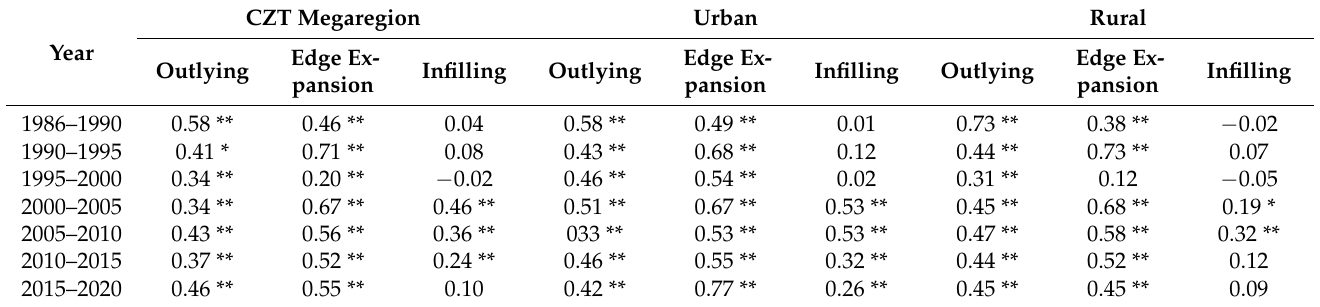
* the coefficient is significant at the 0.05 level; ** the coefficient is significant at the 0.01